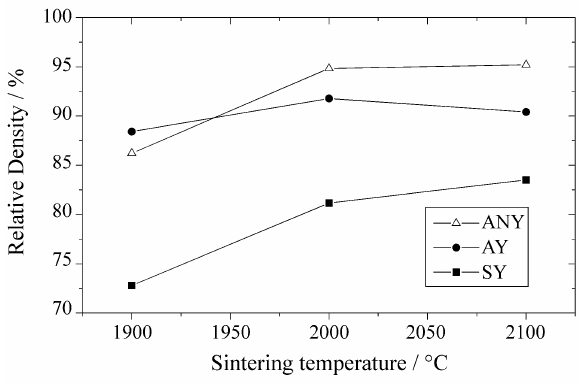
Figure 4. Relative density of the samples vs. sintering temperature.